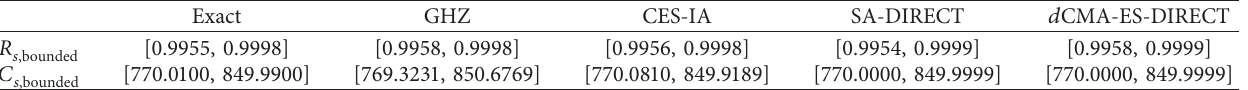
Table 6: The intervals for R d CMA-ES-DIRECT hyperboxes.